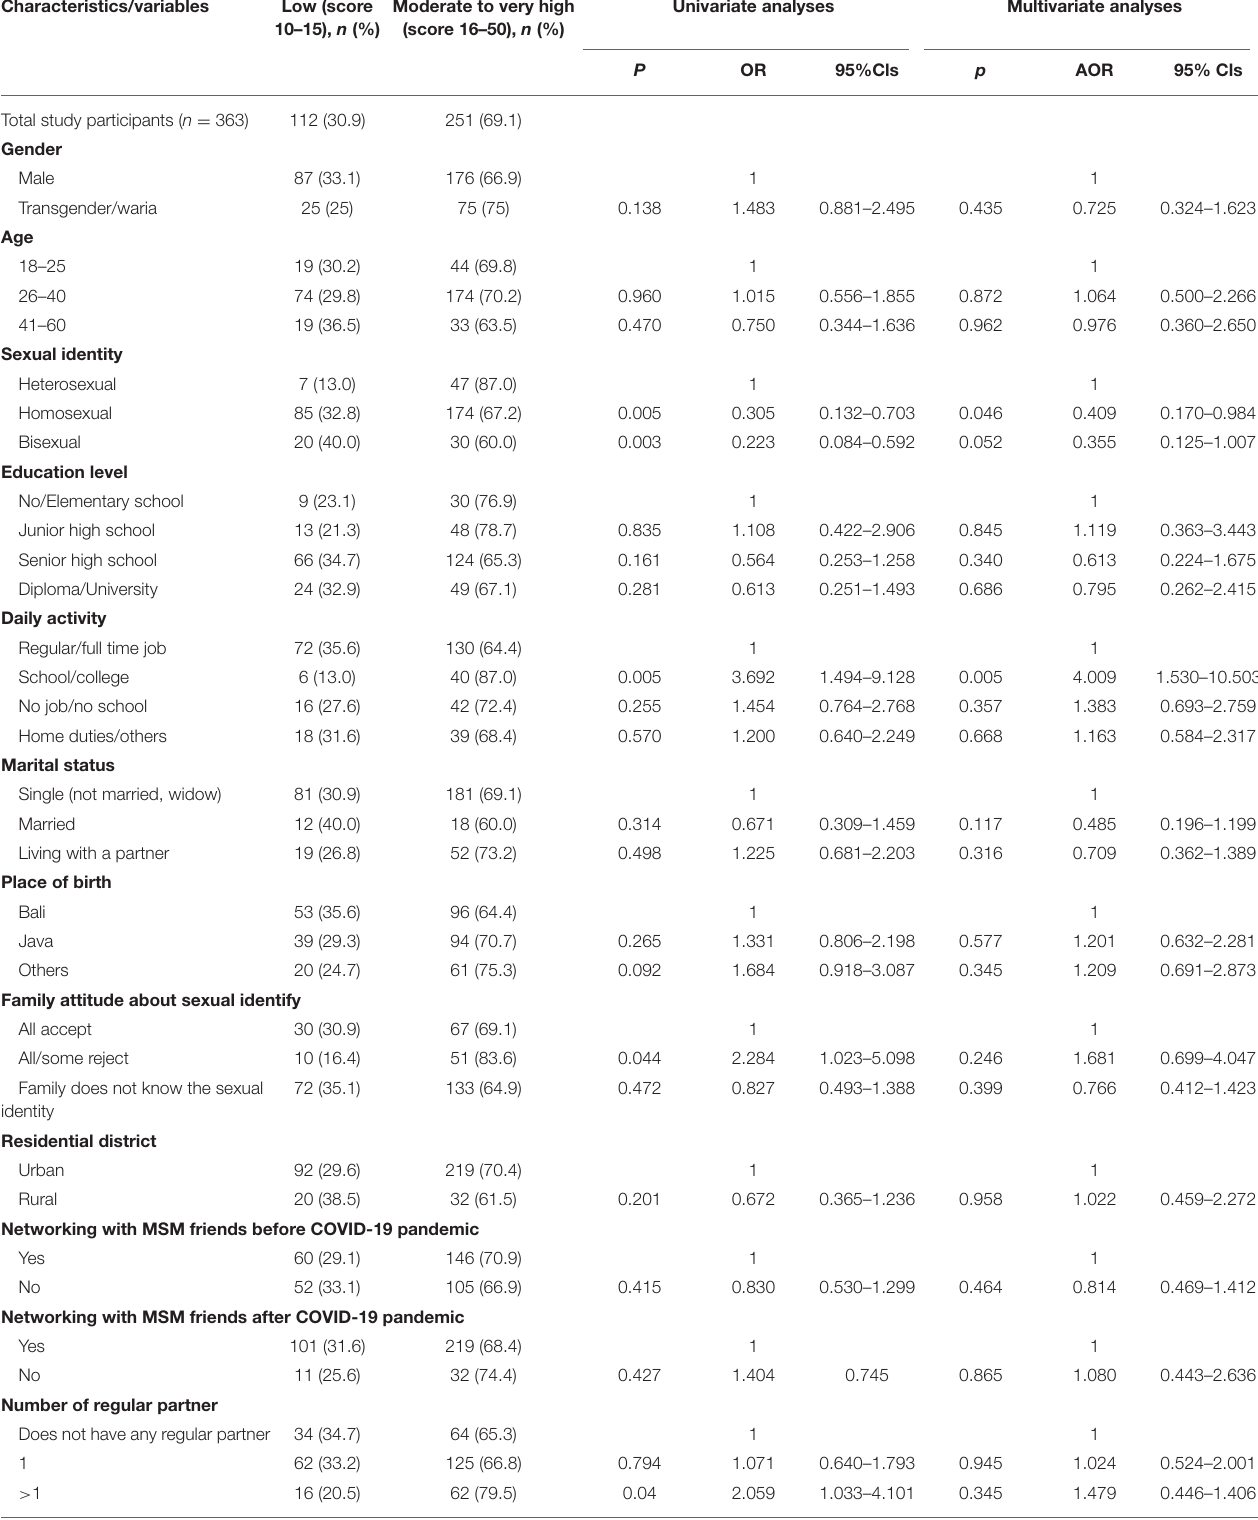
TABLE 3 | Factor associated with psychological distress among the study population (based on K10 score).